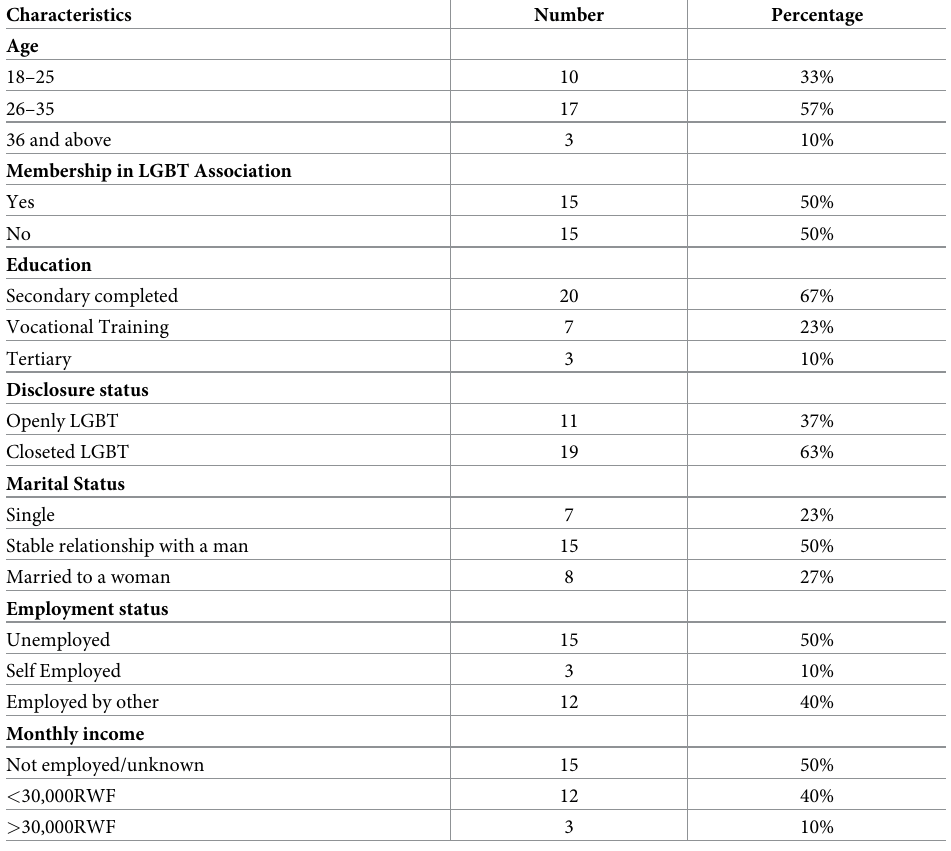
Table 1. Participants demographic and socio-economic